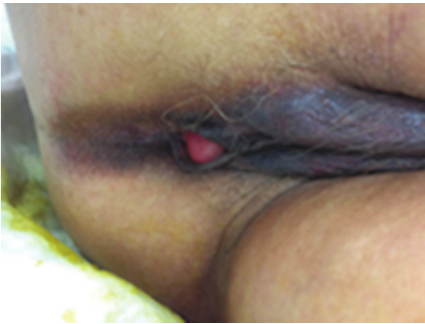
Figure 1: Examination demonstrating congenital absence of exter- nal anus. The rectovestibular fistula is just visible at the posterior aspect of the introitus near the fourchette.